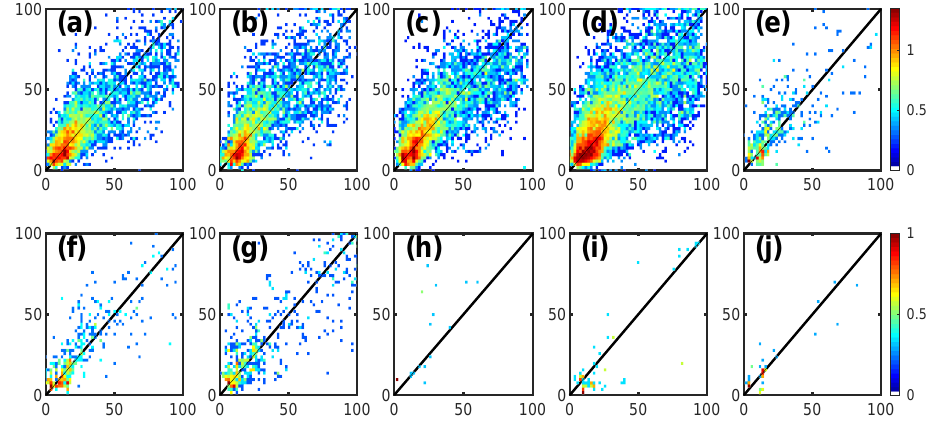
Figure 10. The 2D-histogram plot of FY4A relative humidity (y-axis) and radiosonde relative humidity (x-axis). The FY4A RH cases which are labeled with perfect or good in the vertical range from 280 hPa to surface are selected for plots. 10 sky conditions are in the 10 sub-figures: ( a ): clear, with PCC of 0.7165, ( b ): cirrus, with PCC of 0.6592, ( c ): cirrostratus, with PCC of 0.6859, ( d ): deep convection, with PCC of 0.6593, ( e ): altocumulus, with PCC of 0.5966, ( f ): altostratus , with PCC of 0.6605, ( g ): nimbostratus, with PCC of 0.7231, ( h ): cumulus, with PCC of 0.3752, ( i ): stratocumulus, with PCC of 0.7210, ( j ): stratus, with PCC of 0.8009. All the correlation coefficients are at 95% confidence level. Colors represent the frequency 10 n where n is the value in colorbar. The black line is the identity